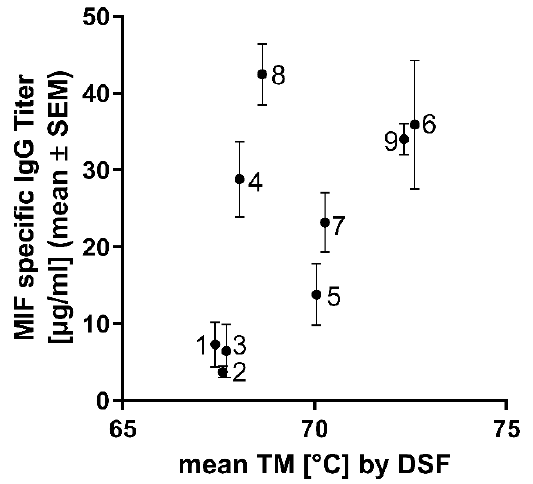
Figure 6. Correlation between thermal stability (Tm) of BaxM159 variants and MIF specific IgG titer. Thermal stability was determined by differential scanning fluorimetry (DSF). Standard error mean (SEM) of MIF specific titer is indicated by whiskers. Numbers indicate the ID of the antibody variants as described in Table 1.